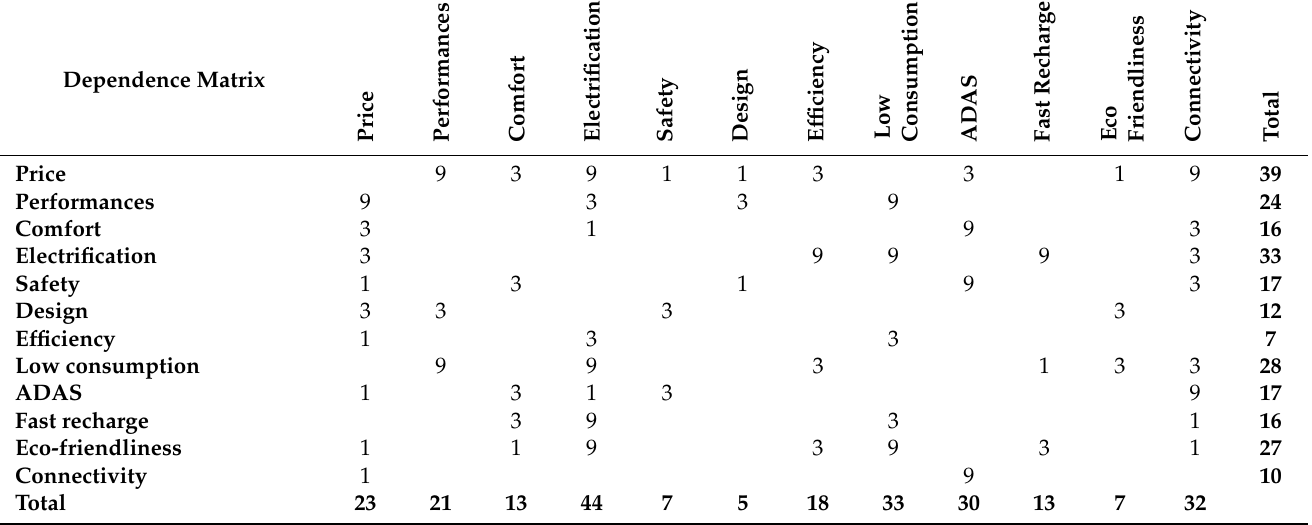
Table 3. Final dependency matrix considered for the